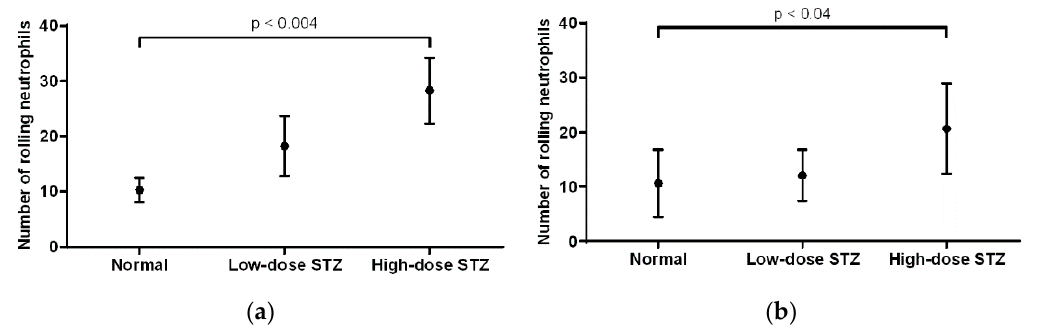
Figure 4. Effects of moderate and severe diabetes in the number of rolling neutrophils. ( a ) Mean values (± standard deviation) of rolling neutrophils in the cremaster muscle of normal and diabetic mice ( n = 6). Compared to normal mice, mice given high doses of STZ exhibited a significant increase ( p < 0.004) in the number of rolling neutrophils. Overall, diabetic mice showed an increased number of rolling neutrophils compared to that of normal mice. ( b ) Mean number of rolling neutrophils in the earlobe of normal, low-dose STZ, and high-dose STZ diabetic mice. Compared to normal mice, mice given high dose of STZ exhibited an increase in the number of rolling neutrophils ( p < 0.04). Overall, diabetic mice showed an increased number of rolling neutrophils compared to that of normal mice.